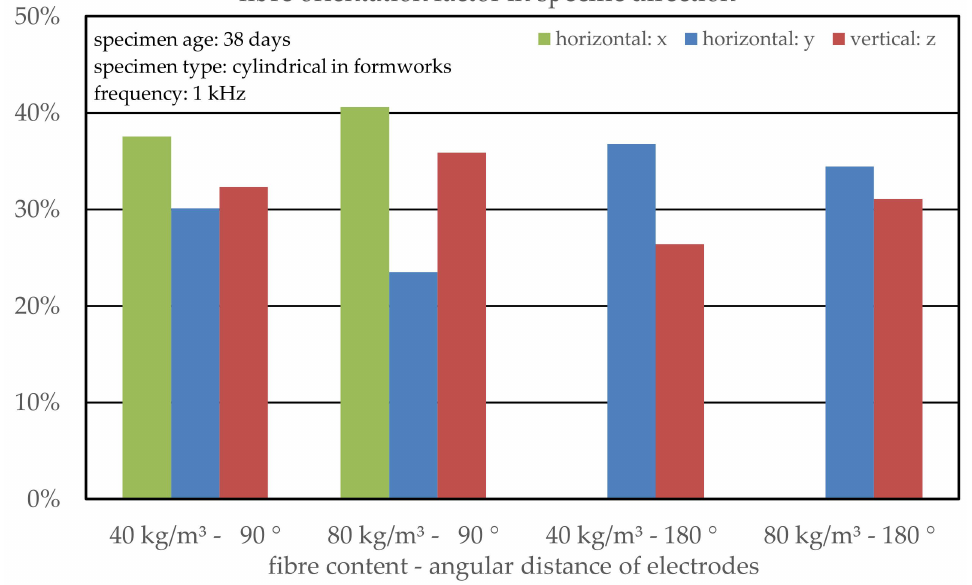
Figure A7. Calculated fibre orientation of the concrete specimens with different electrode arrays depending on the fibre content at a specimen age of 38